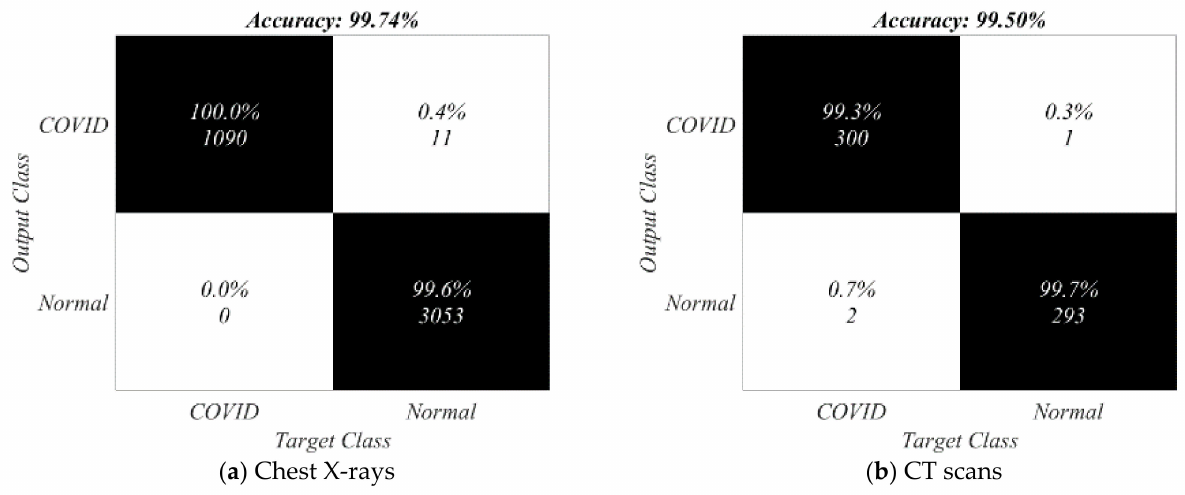
Figure 8. Confusion matrices of the first stage of the proposed framework for ( a ) chest X-rays and ( b ) CT scans.